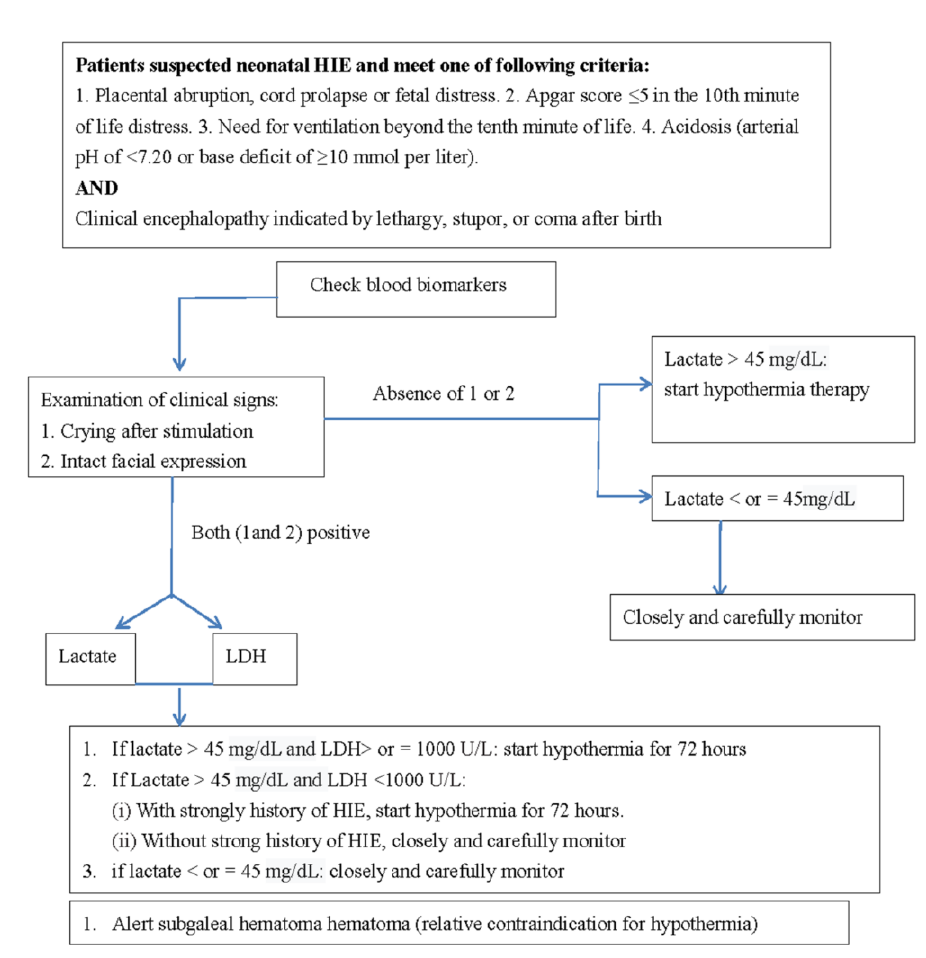
Figure 3. Feasible approach for treating patients with neonatal HIE.